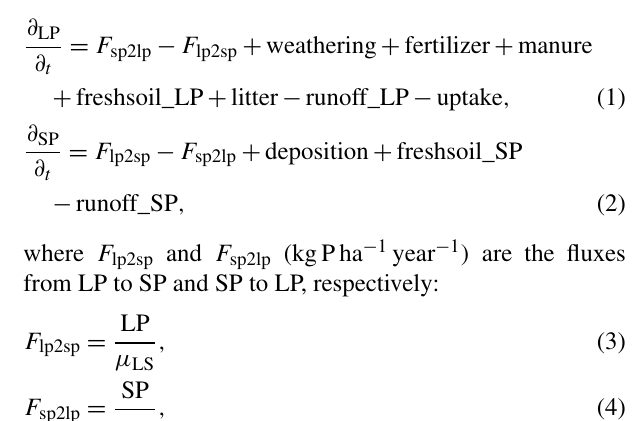
3. Dynamic transfer between different soil P pools 4. Initialization P pools with global observation 5. Dynamic P loss by runoff